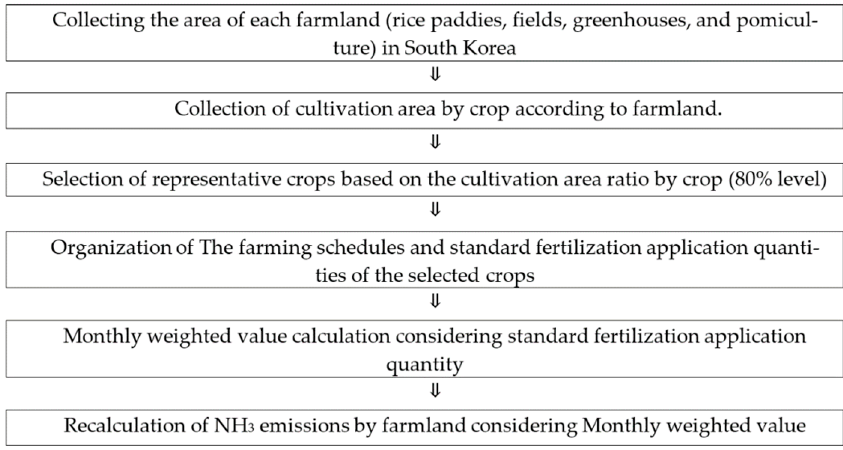
Figure 2. Spatial-Temporal resolution improvement work flow-chart (Method